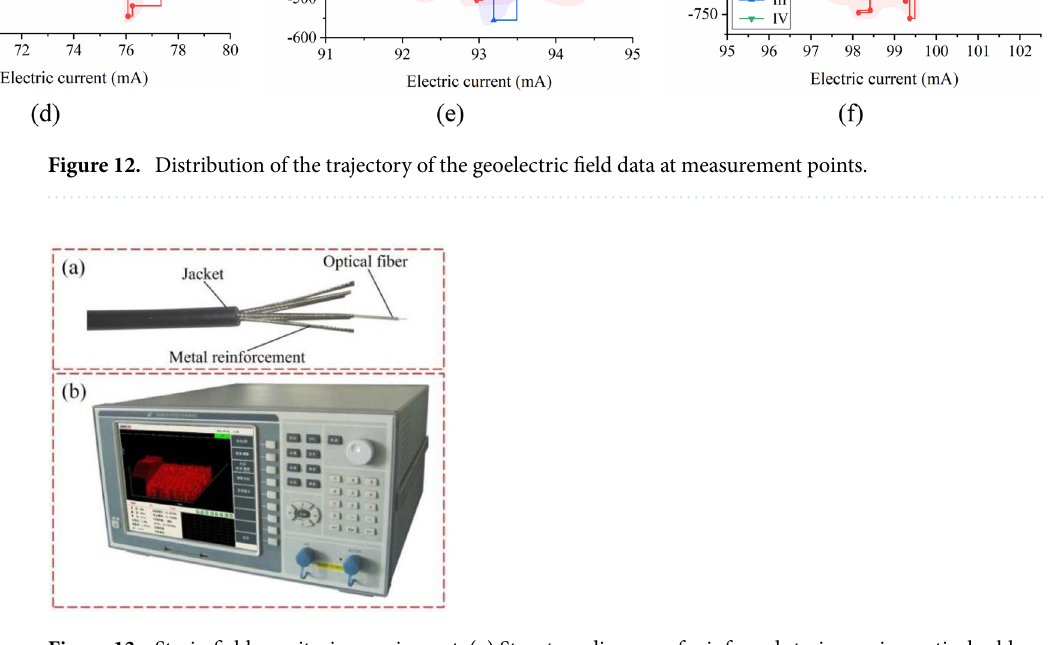
Figure 13. Strain field monitoring equipment. ( a ) Structure diagram of reinforced strain sensing optical cable; ( b ) BOTDR optical fiber